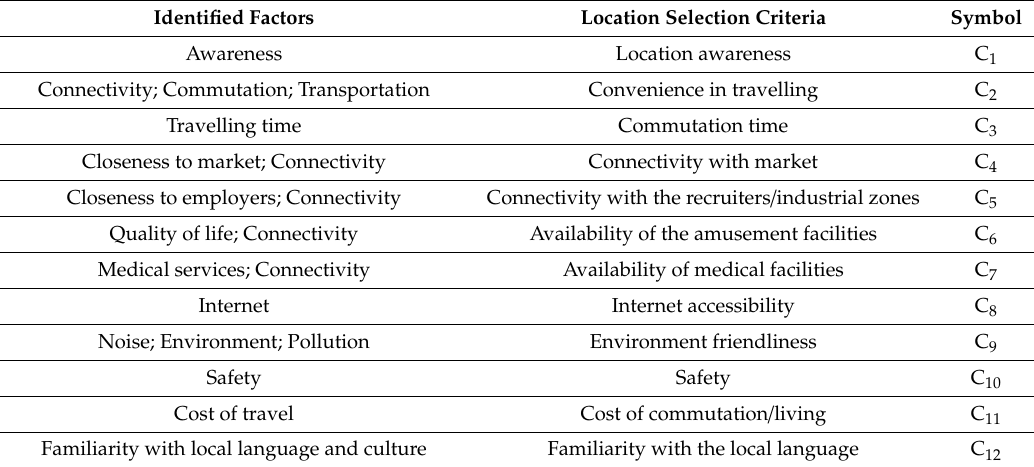
Table 3. Criteria for facility location